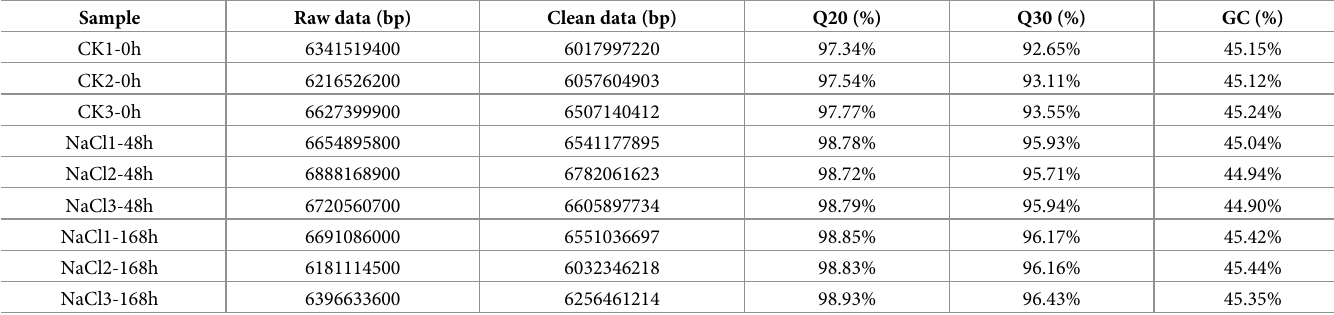
3.6 KEGG pathway analysis of DEGs in T . ramosissima leaves under NaCl stress KEGG pathway analysis showed that 1762 and 1366 DEGs were annotated in the comparison group Table 1. Filtered reads quality